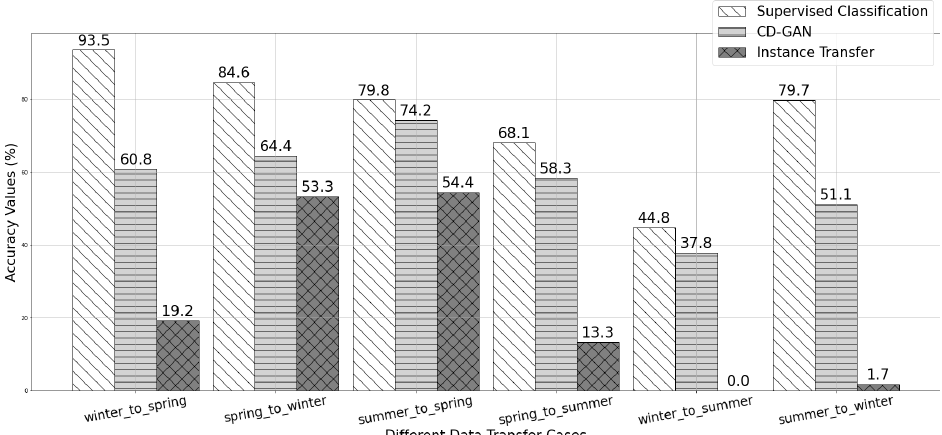
Figure 8. Comparison of the FDD performance by training classifiers with fault data from different sources. Bars filled with cross stripes: ground truth testing data, denoted as full-knowledge super- vised classification (upper bound). Bars filled with diagonal stripes: ACDG generated fault data. Bars filled with grids: data directly borrowed from the source domain, which is denoted by simple instance transfer (lower